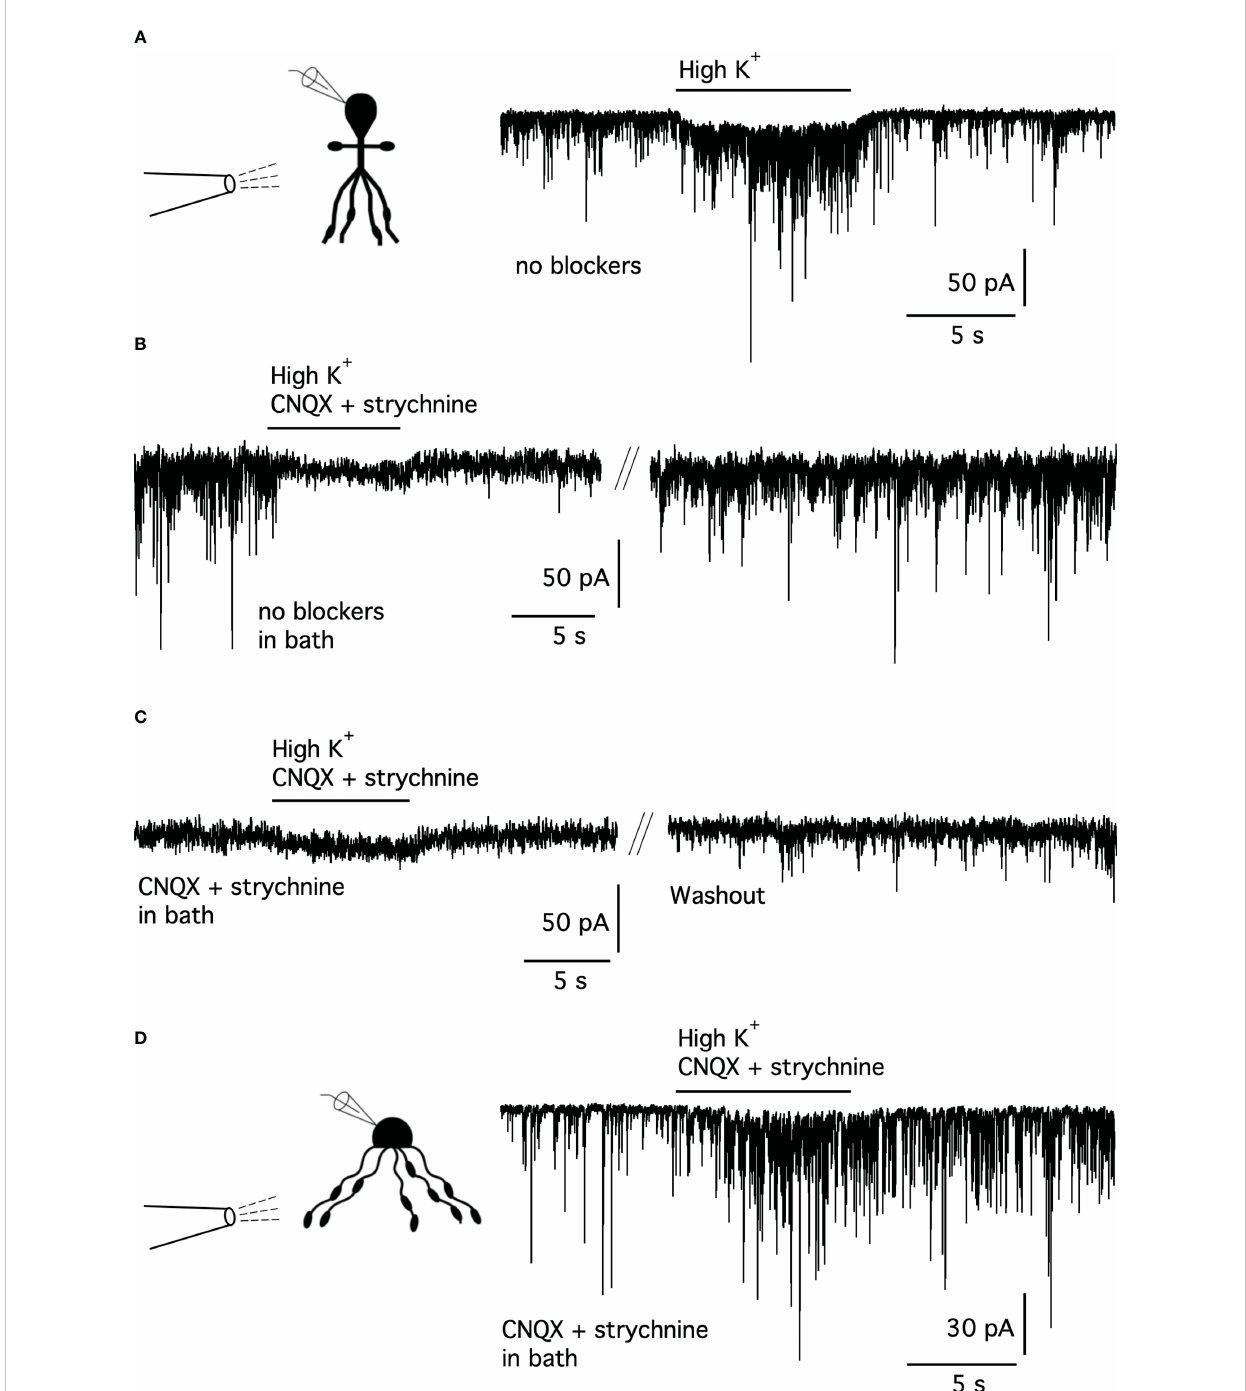
FIGURE 2 High-K + stimulation of synaptic release from presynaptic terminals does not evoke synaptic currents mediated by GABA receptors in AII amacrine cells. (A) Puffer pipette application of high-K + solution (HEPES-buffered extracellular solution with [K + ] increased from 2.5 to 22.5 mM) onto an AII amacrine ( V hold = -60 mV, E Cl ~ 0 mV) evoked a marked increase in postsynaptic currents (PSCs). Here and in (D) , experimental con fi guration and identity of cell from which the recording was made indicated by the schematic (inset, left). No blockers present in puffer pipette solution or in bath. Here and later, duration of application indicated by horizontal bar above current trace. (B) When high-K + puffer pipette solution with CNQX (10 µM) and strychnine (300 nM) was applied to an AII amacrine cell (different cell than in (A) ; no blockers in bath), all PSCs were blocked (left). After a short period of washout (~20 s; marked by parallel lines), the PSCs fully recovered (right). (C) When application of high-K + solution with CNQX and strychnine to the AII amacrine cell (same as in (B) ) was repeated after adding CNQX (10 µM) and strychnine (300 nM) to the bath solution, PSCs were blocked both before and during application. In this condition, application of high-K + solution evoked a small inward current, probably corresponding to the local depolarizing shift of E K . After a period of washout (~10 min; marked by parallel lines), the PSCs partially recovered (right). (D) Recording from an A17 amacrine cell ( V hold = -70 mV, E Cl ~ 0 mV). High-K + solution (with 10 µM CNQX and 300 nM strychnine in both puffer pipette and bath) evoked an increase of PSCs. Note that the increased frequency of PSCs outlasted the period of application of high-K +